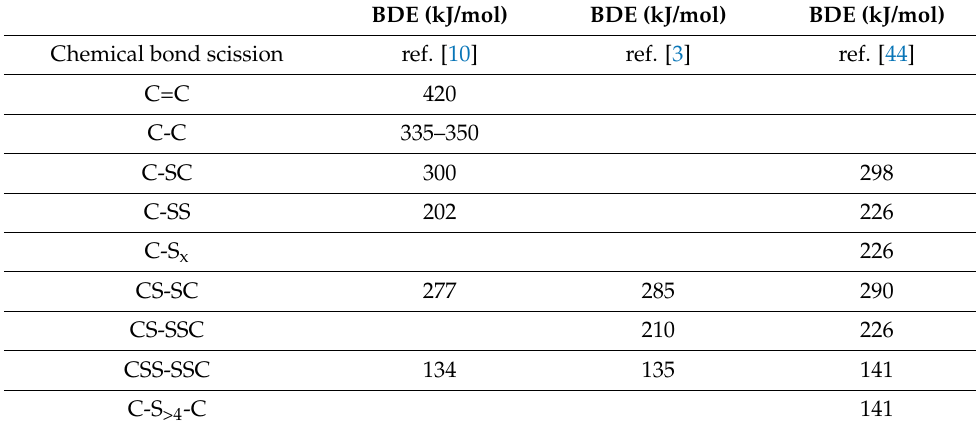
Table 6. Bond dissociation energy (BDE) of chemical bonds involved in vulcanized networks. BDE (kJ/mol) BDE (kJ/mol) BDE (kJ/mol) Chemical bond scission ref. [10] ref. [3] ref. [44] C=C 420 C-C 335–350 300